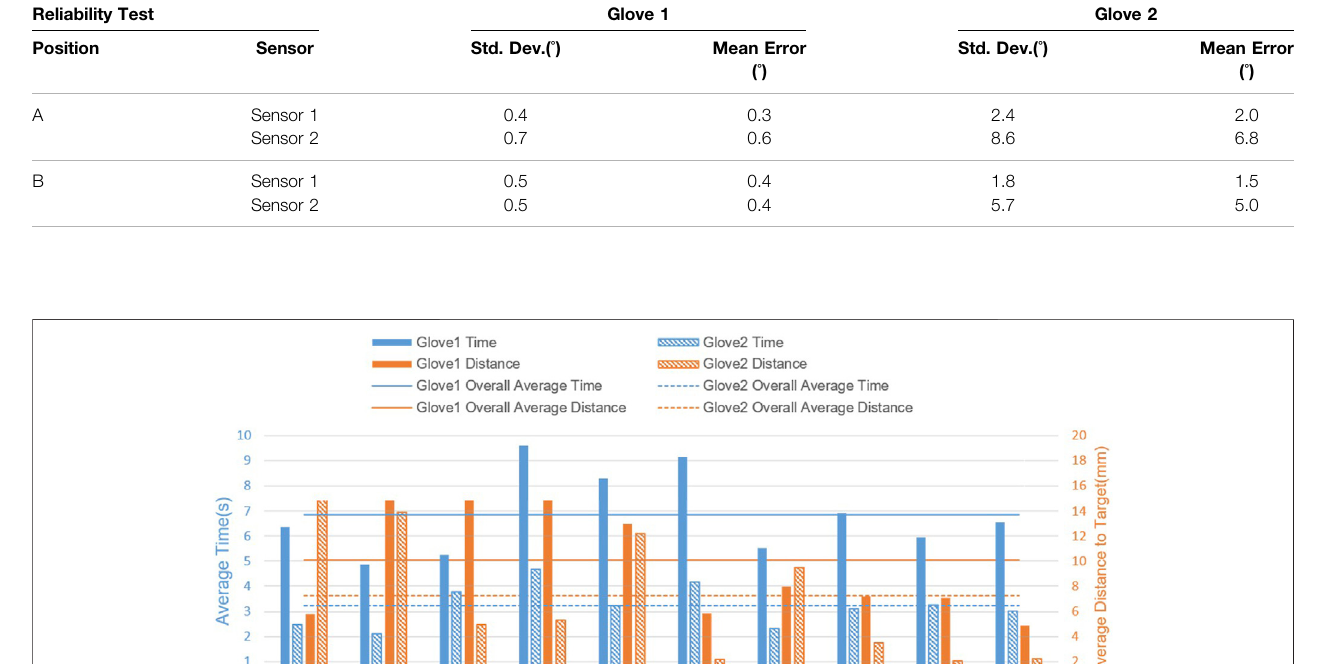
TABLE 1 | Results of precision test for index fi nger.